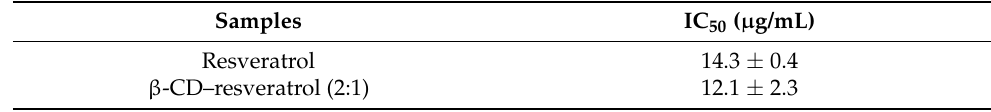
Table 5. Antioxidant activity of resveratrol and β -CD–resveratrol a .